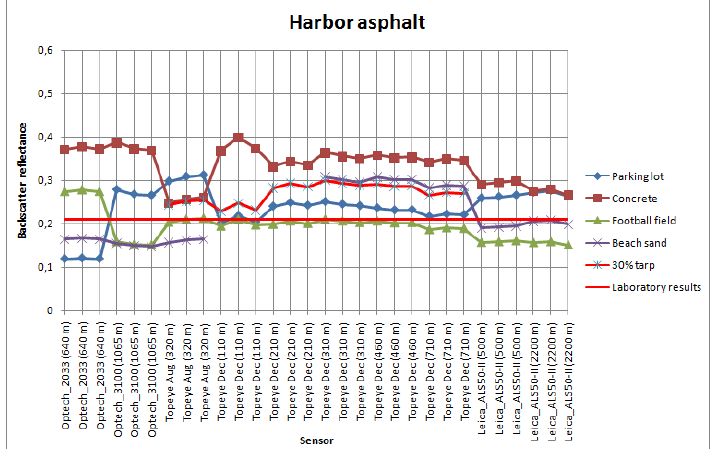
Figure. 7F. Backscatter reflectances of the harbor asphalt sample calibrated with different samples as